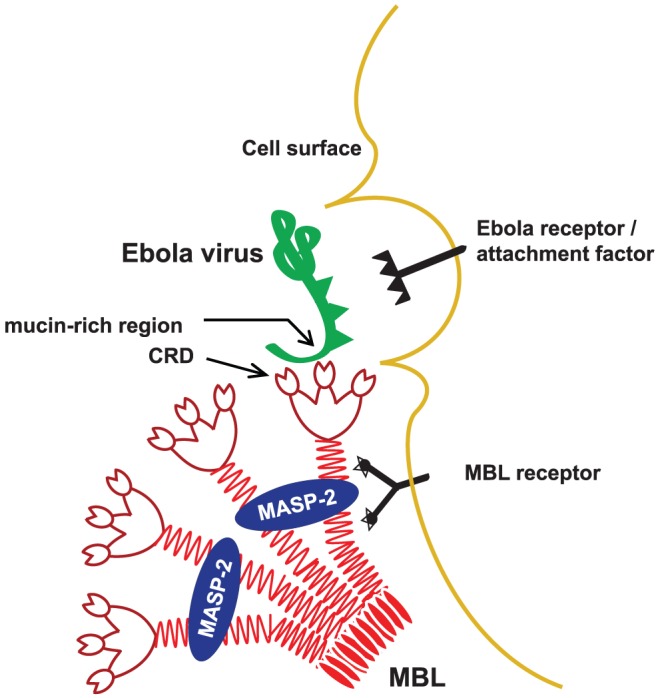
Proposed model of MBL-mediated macropinocytosis of EBOV.MBL carbohydrate recognition domains (CRD) bind to highly glycosylated mucin-rich regions of EBOV GP and the MBL-virion complex is presented to the cell surface. Then MBL binds to cognate cellular receptors, such as C1QBP or calreticulin [6] via MBL collagenous stalks. In this manner, MBL concentrates virus at the cell surface and may facilitate cross-linking of EBOV to its cognate receptor or to other attachment factors such as dectin-2, which may facilitate subsequent membrane fusion and internalization. The relatively large size of EBOV particles (800 to 1,400 nm) is amenable to bulk fluid-phase uptake pathways such as macropinocytosis which is the canonical pathway for EBOV entry. Our data indicate that MBL also mediates internalization of virus via macropinocytosis but suggests that MBL-mediated uptake preferentially utilizes microtubules compared with the canonical EBOV pathway which is dependent on both microtubules and actin.